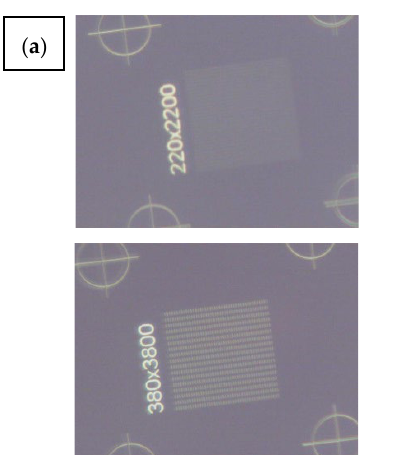
Figure 7. Images of longer dipole structures acquired by transmittance microscopy at visible wave- lengths; whole dipole arrays ( a ); details of dipole arrays ( b ).